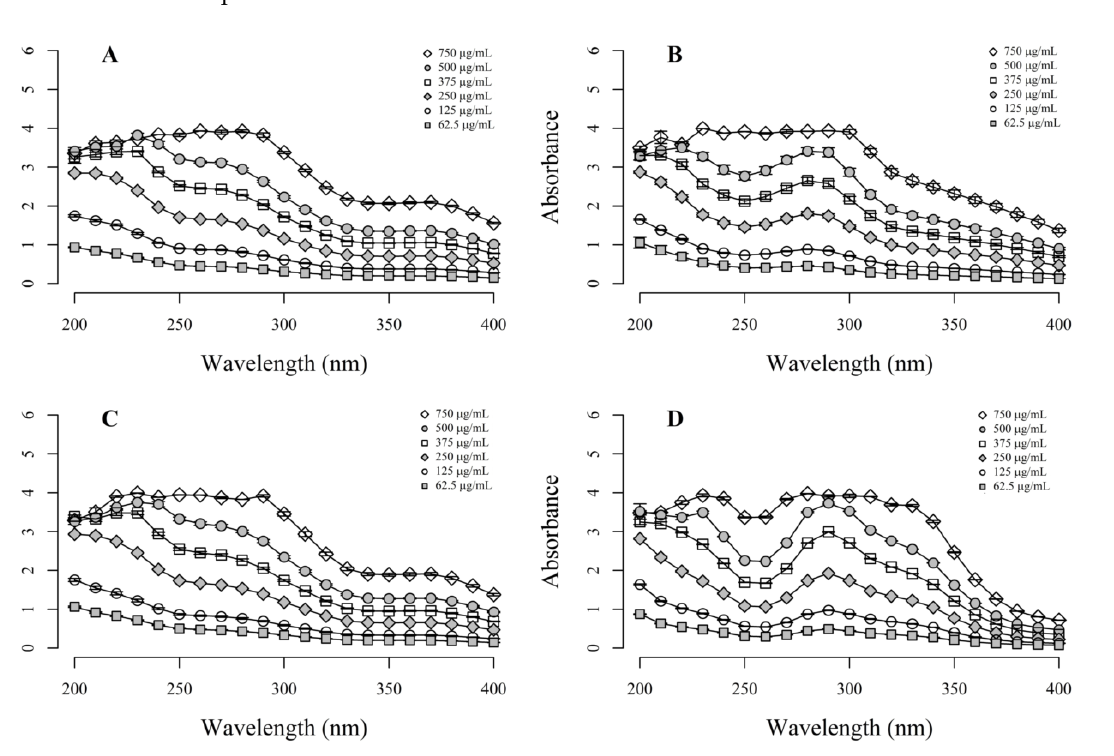
Figure 1. UV absorbance spectra of the flower extracts obtained from: ( A ) R. centifolia pink, commer- cial variety, ( B ) R. centifolia fuchsia, commercial variety, ( C ) P. latifolia , and ( D ) I. horsfalliae . Error bars indicate the standard error of the mean for at least three independent experiments ( n =